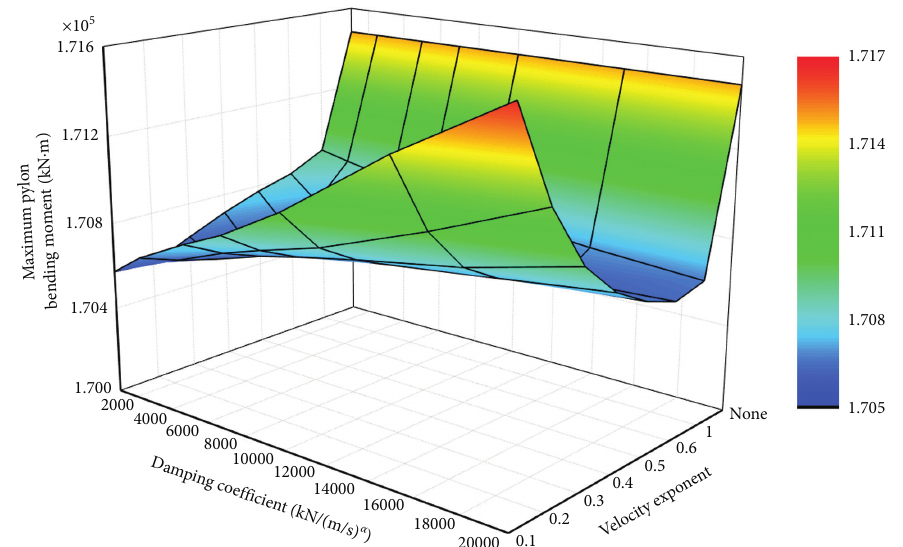
Figure 21: Maximum pylon bending moment M